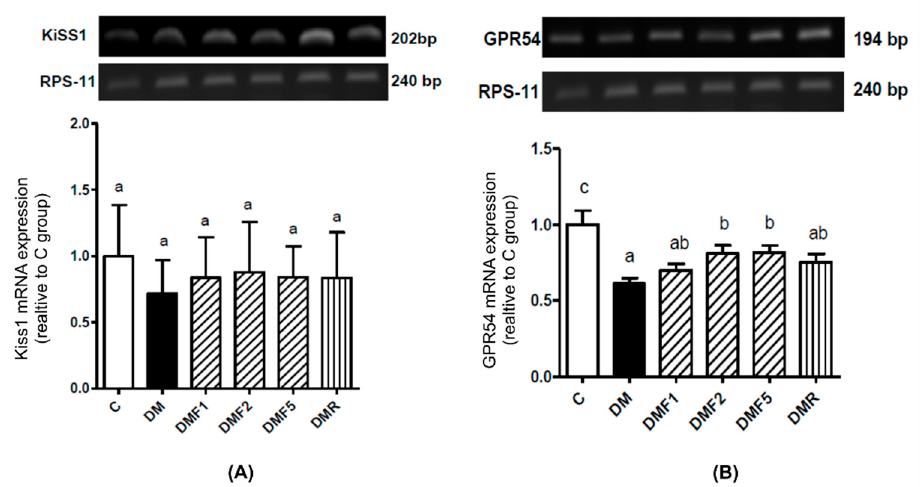
Figure 7. Effects of fucoxanthin on relative ( A ) Kiss1 and ( B ) GPR54 mRNA expression in rat hypothalamus after treatment for four weeks. Data are shown as the mean ± S.D. ( n = 5). The values with different letters (a–c) represent significant differences ( p < 0.05) as analyzed by Duncan’s multiple range test. C, control; DM, diabetes; DMF, diabetes treated with fucoxanthin; DMR, diabetes treated with rosiglitazone; GPR54, G-protein coupling receptor (Kiss1 receptor).